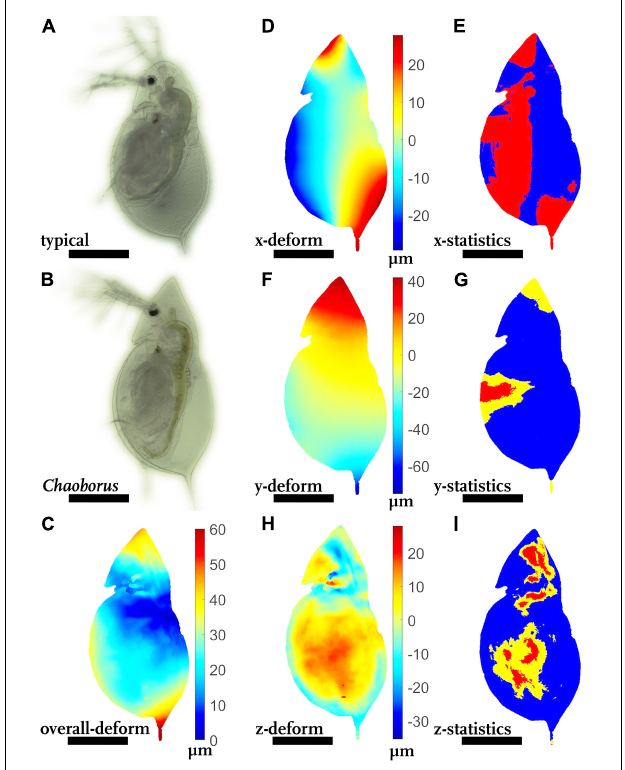
FIGURE 2 | Morphological alterations of Chaoborus -exposed Daphnia cucullata . (A) D. cucullata , reared in the absence of Chaoborus -kairomones. (B) D. cucullata , reared in the presence of predator kairomones. (C) Overall deformation plot showing the comparison of the unexposed and Chaoborus -exposed D. cucullata model. Plotted are the vector lengths ( µ m) between the respective vertices on the unexposed and the Chaoborus -exposed D. cucullata model (blue 0 µ m displacement, dark red 60 µ m displacement). (D,F,H) Shades of blue colors represent alterations in negative direction, while shades of red display shifts in the positive direction. Shades of yellow to white indicate little or no shifts along the respective axis. (E,G,I) P -values lower than 0.05 displayed in yellow, regions supported by q -values lower than 0.05 are colored red. (D) Vertex displacements ( µ m) in x-(dorso-ventral) direction. (E) Wilcoxon test p -values and FDR-analysis q -values for each vertex position of the x-direction. (F) Vertex displacements in y-(longitudinal) direction ( µ m). (G) Wilcoxon test p -values and FDR-analysis q -values for each vertex position of the y-direction. (H) Vertex displacements in z-(lateral) direction ( µ m). (I) Wilcoxon test p -values and FDR-analysis q -values for each vertex position of the z-direction. n undefended = 10, n defended = 10. All scale bars: 600 µ m.